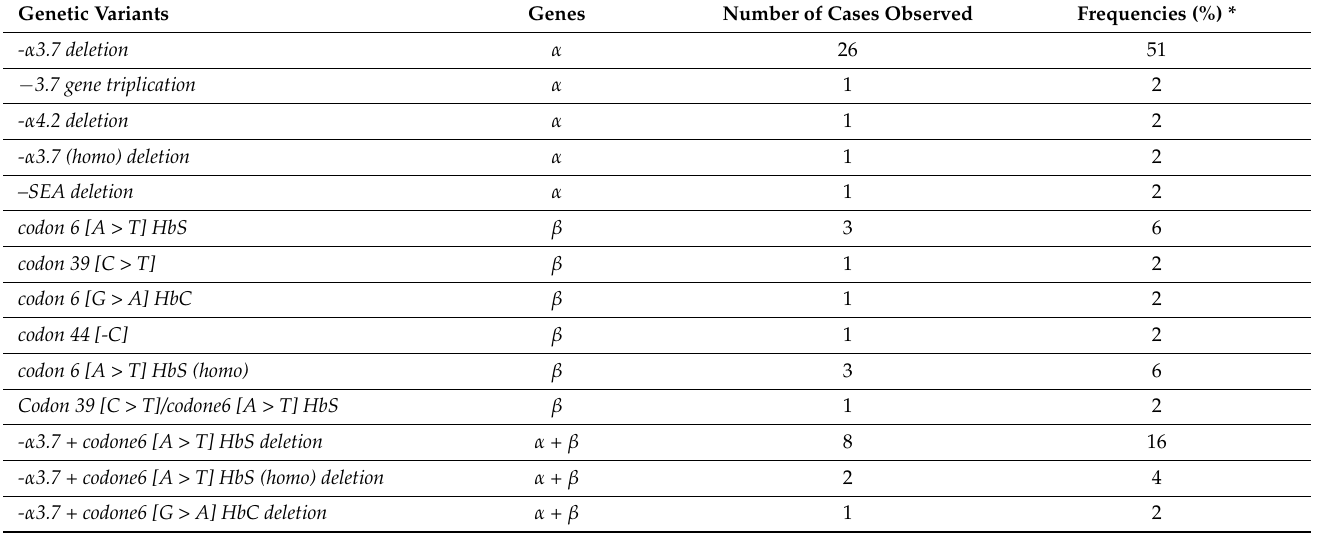
Table 1. Frequencies of the mutations in the analysed genes in the migrants group.